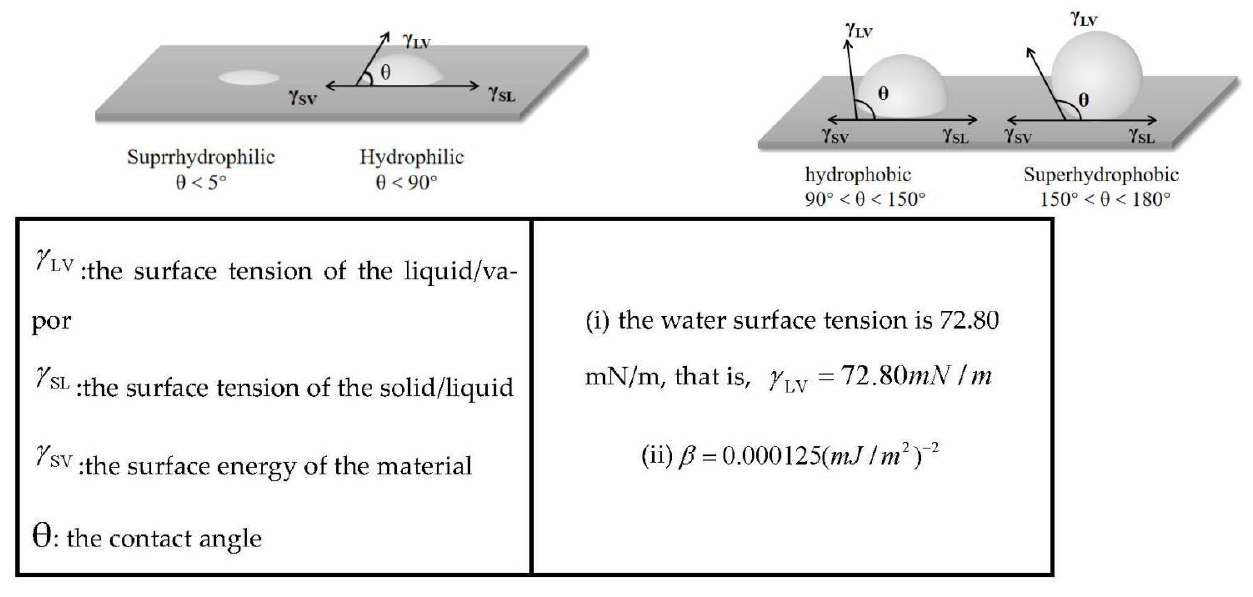
Figure 6. A schematic diagram of several parameters.